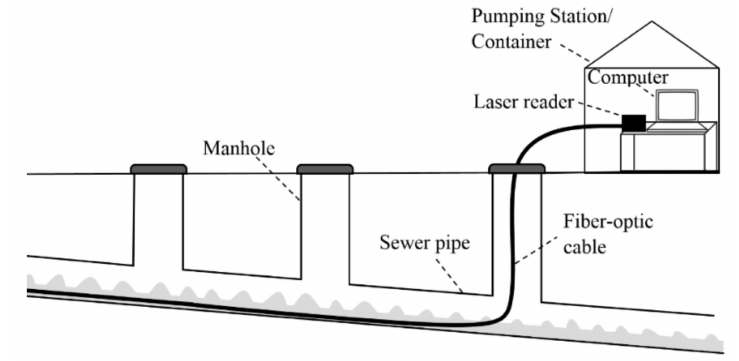
Figure 1. Standard layout of the distributed temperature sensing (DTS) technique in a sewer network and the control unit stored outside the sewer system in a pumping